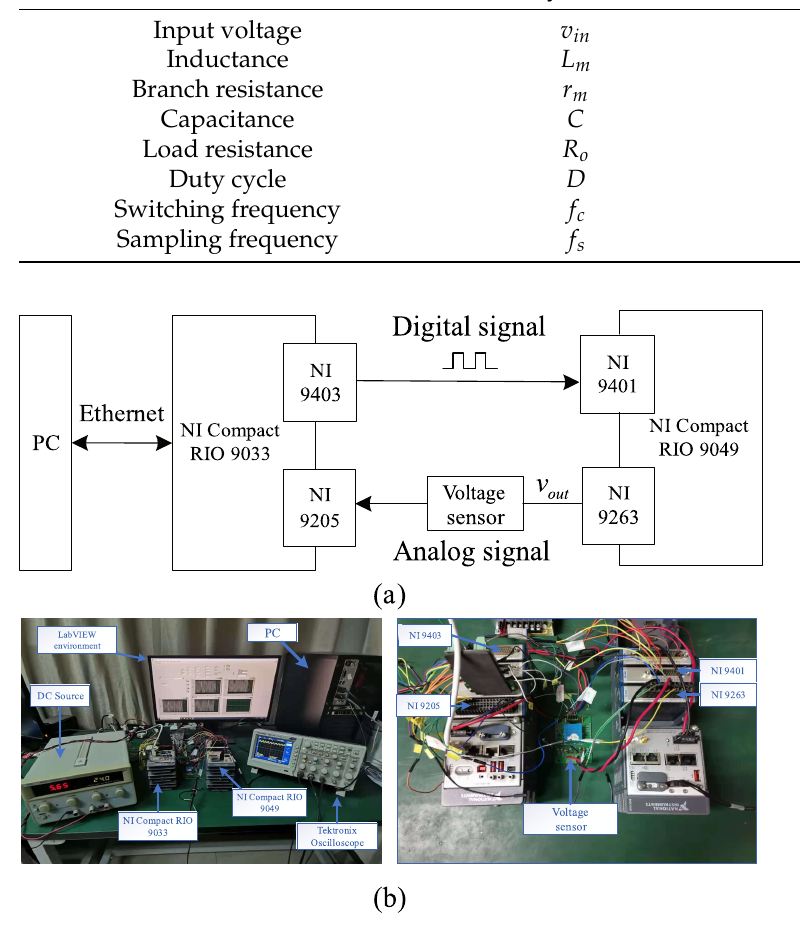
Figure 7. The test platform. ( a ) Block diagram, and ( b ) experimental test